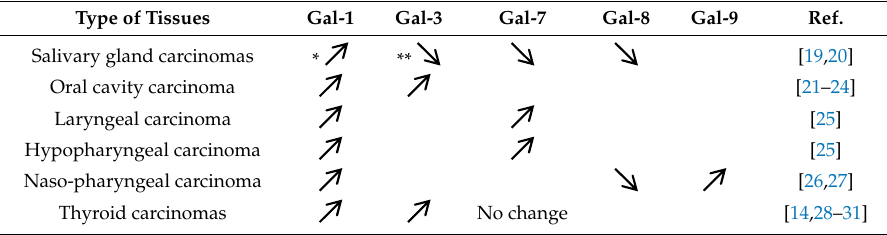
Table 1. Galectin-1, -3, -7, -8, and -9 expression during carcinogenesis of head and neck and thyroid carcinomas.